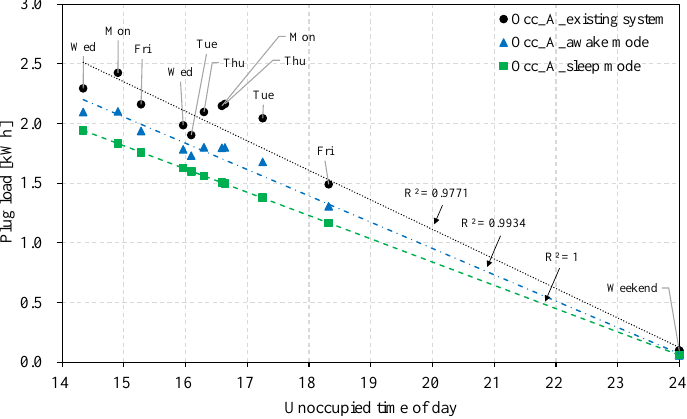
Figure 18. Occupant A, unoccupied time and plug load.